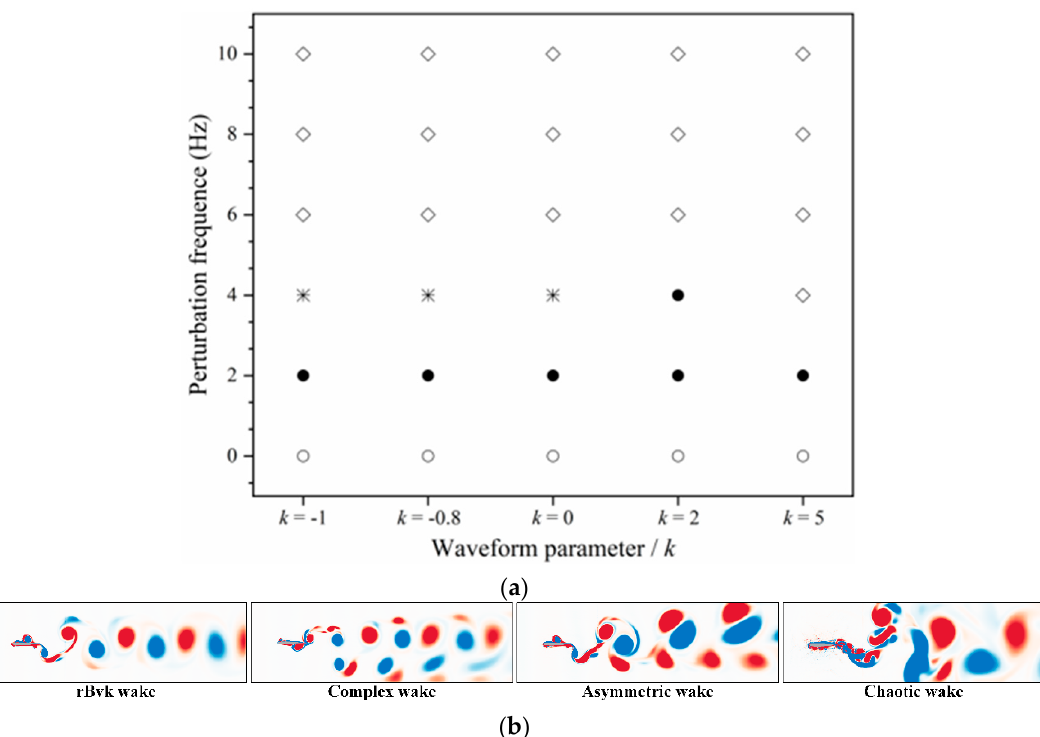
Figure 7. The numerical points in the ( k , f p ) plane for the heaving foil. ○ : reverse Bénard – von Kármán (rBvk) wake; ● : asymmetric wake; ❊ : complex wake; ◊ : chaotic wake. ( a ) Represents the ( k , fp ) map and ( b ) presents examples of the wake structures.